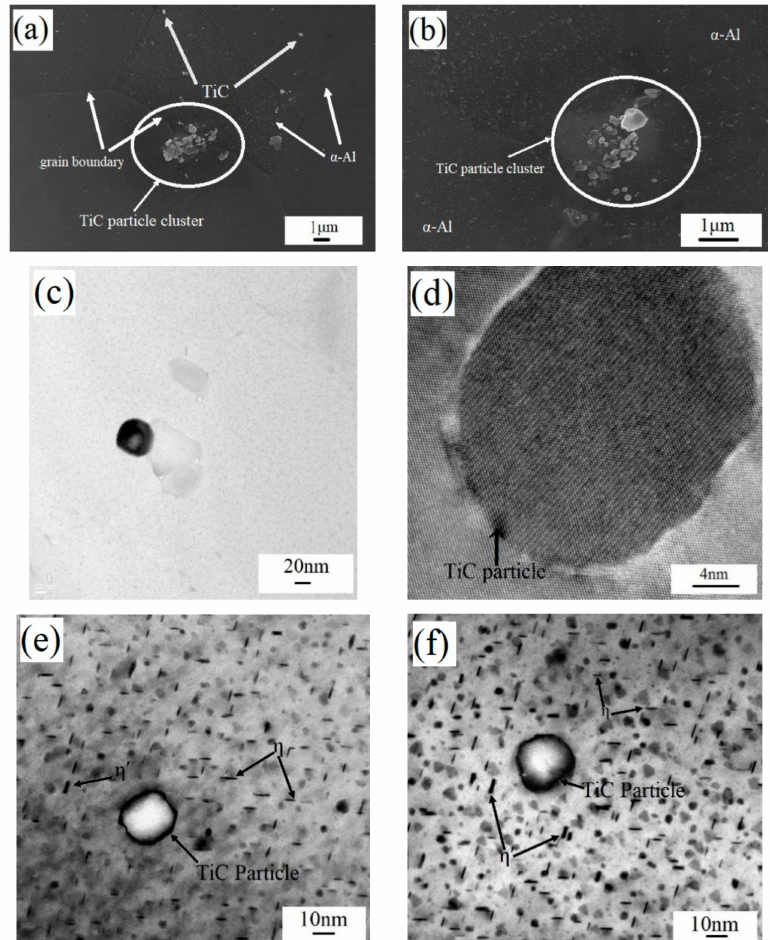
Figure 11. TEM diagram of TiC / 7085 composite. ( a , b ) SEM micrographs of TiC / 7085 composites; ( c ) TEM micrographs of nano TiC particles in the TiC / 7085 composites; ( d ) HRTEM image of interface between TiC particles and α -Al matrix; ( e , f ) TEM and micrographs of the η , η (cid:48) and TiC